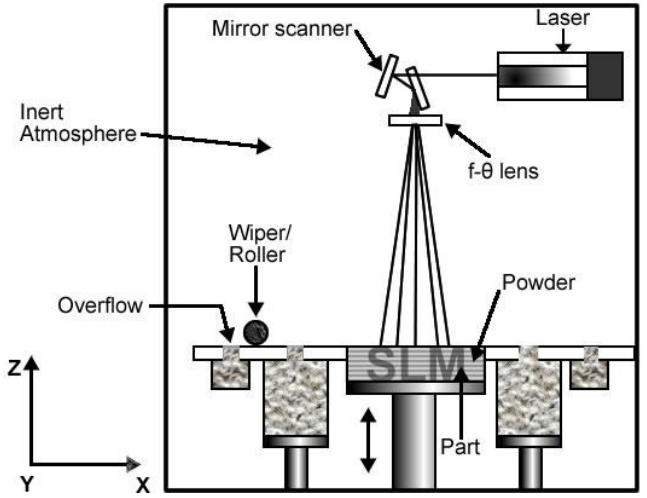
Figure 3. Schematic overview of selective laser melting (SLM)